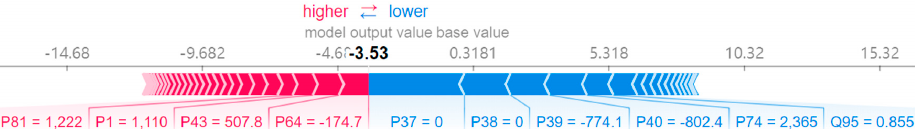
Figure 7. ( a ) SHAP dependence of θ 3 ; ( b ) SHAP dependence of θ 2 ; ( c ) SHAP dependence of P 2-30 ; ( d ) SHAP dependence of Q 2-35 .